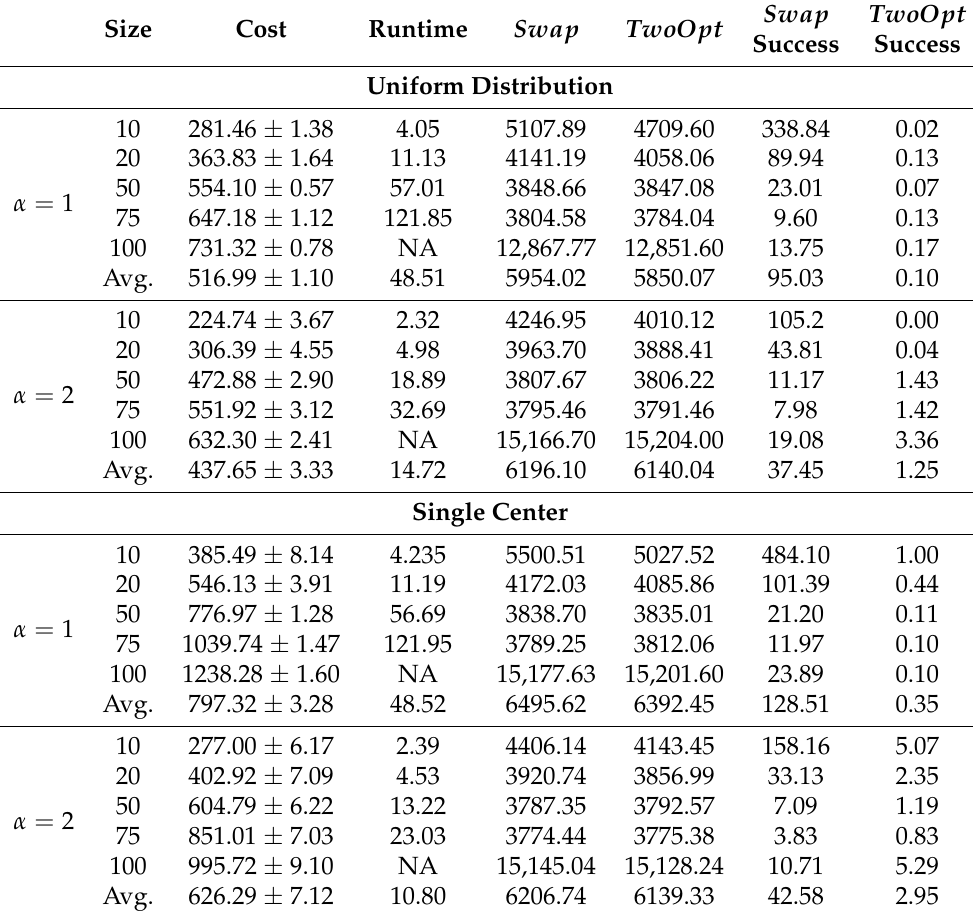
Table 2. Results obtained with the proposed GRASP approach, HCLS variant. Size Cost Runtime